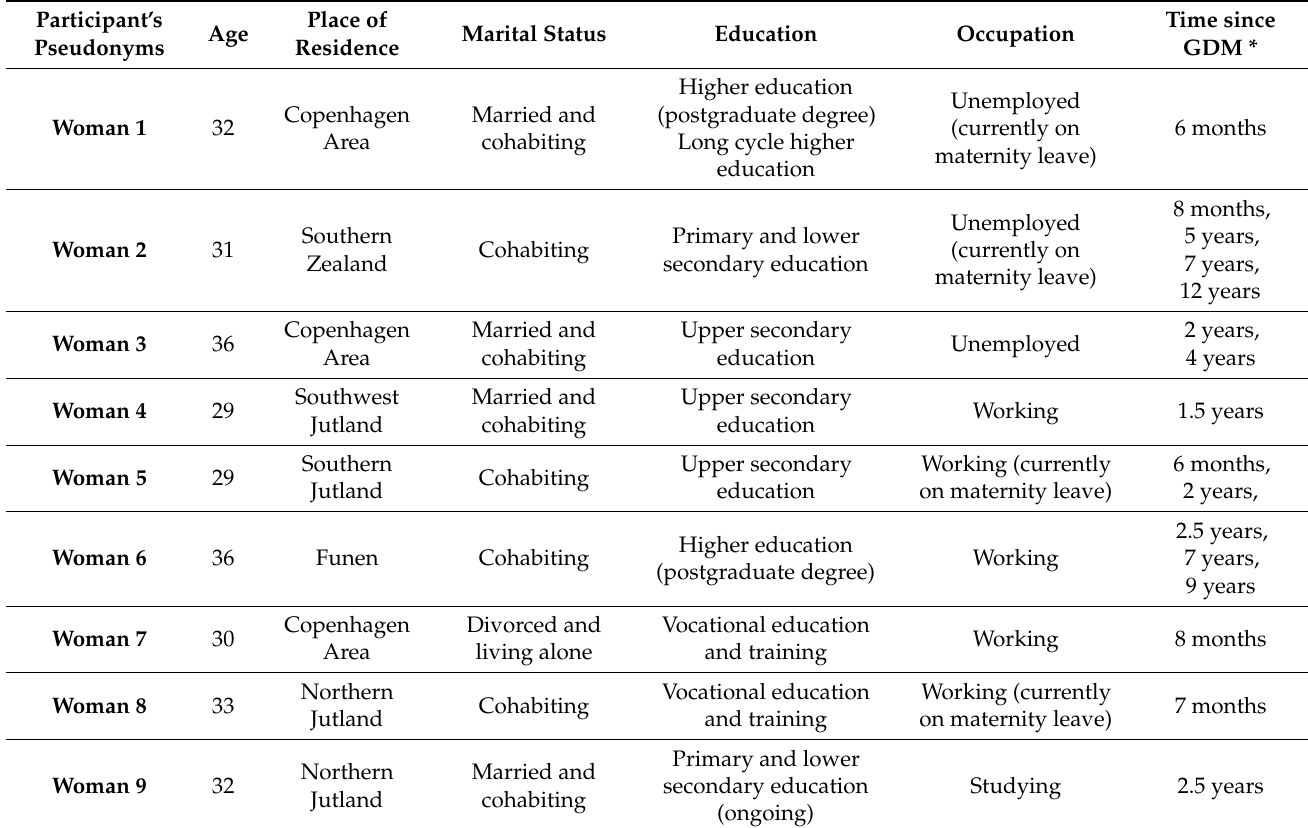
Table 1. Characteristics of study